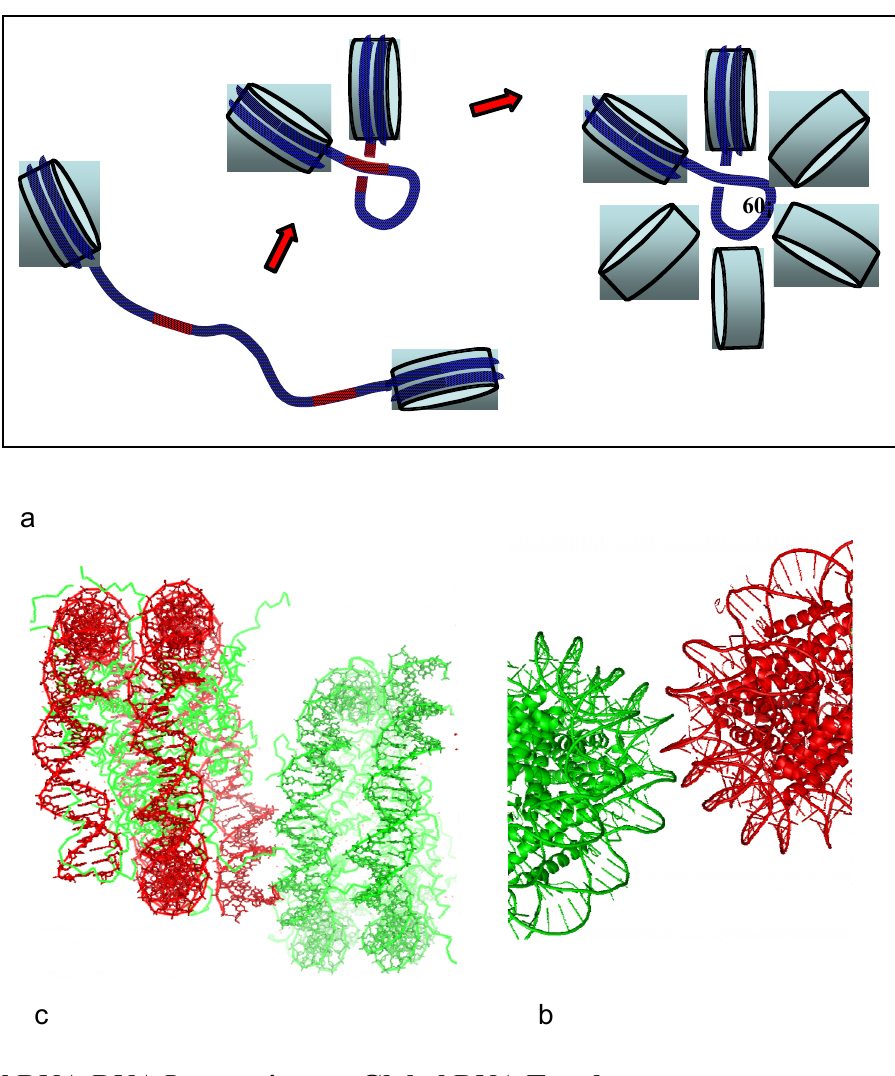
Figure 5. DNA-DNA interactions control the assembly of the chromatin fibre. ( a ) The model proposes that DNA geometry and sequence contribute to organise tighly packed regions in chromatin. The GC sequences suitable to form tight DNA-DNA interactions are represented in red. The geometric constraints imposed by the groove-backbone interaction influence the overall architecture of the fibre; ( b ) and ( c ) Right-handed crossovers between nucleosomal DNA observed in their crystal structure of [47] and [48],